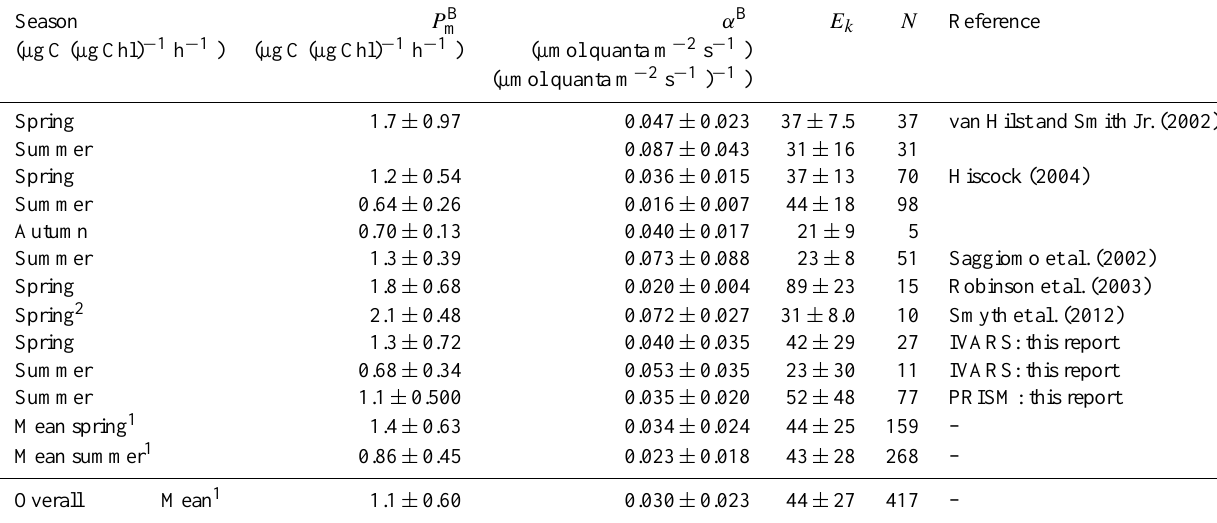
Table 4. Seasonal comparison of photosynthetic parameters from the Ross Sea.